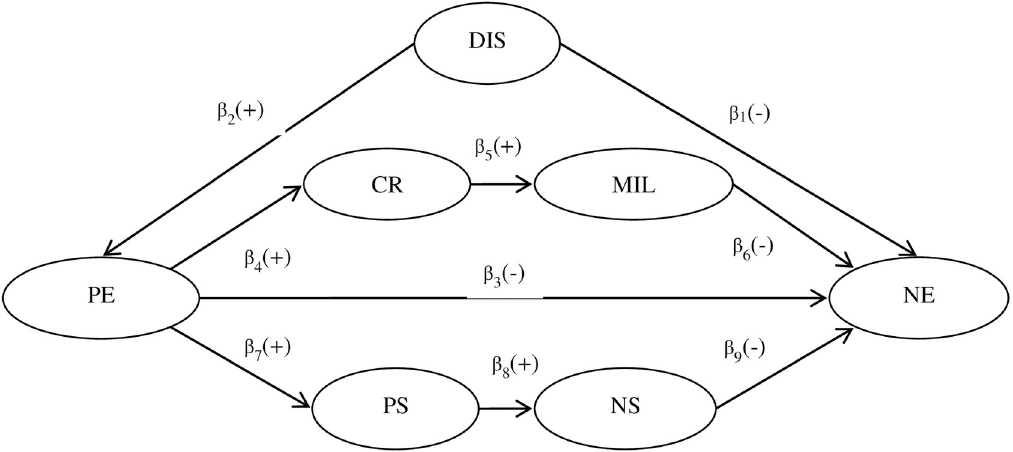
Fig 1. Hypothetical multiple mediators model between distraction and negative emotions. DIS = distraction; PE = positive emotions; CR = cognitive reappraisal; MIL = meaning in life; PS = problem-solving; NS = needs satisfaction; NE = negative